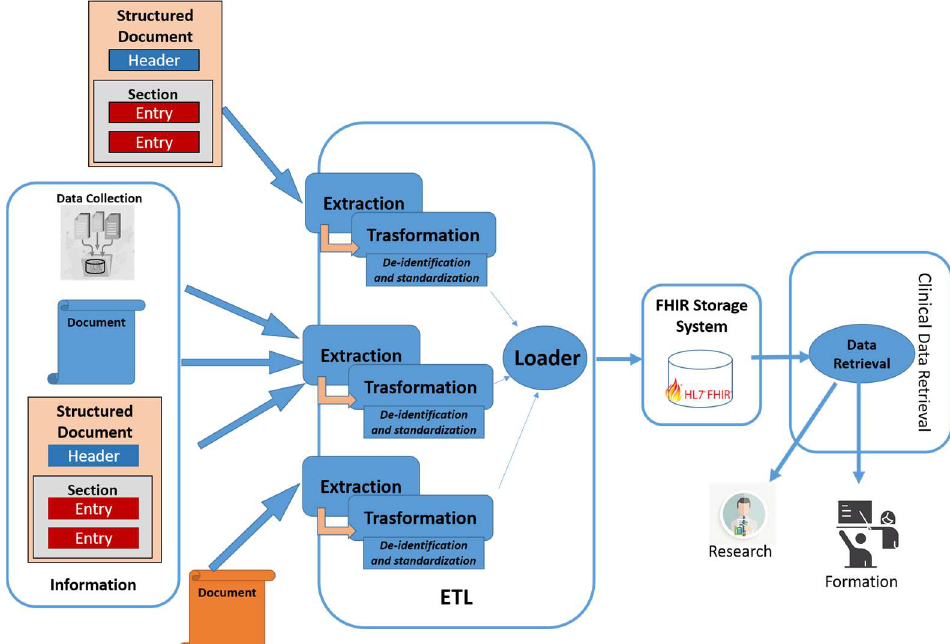
Figure 1. Proposed architecture.